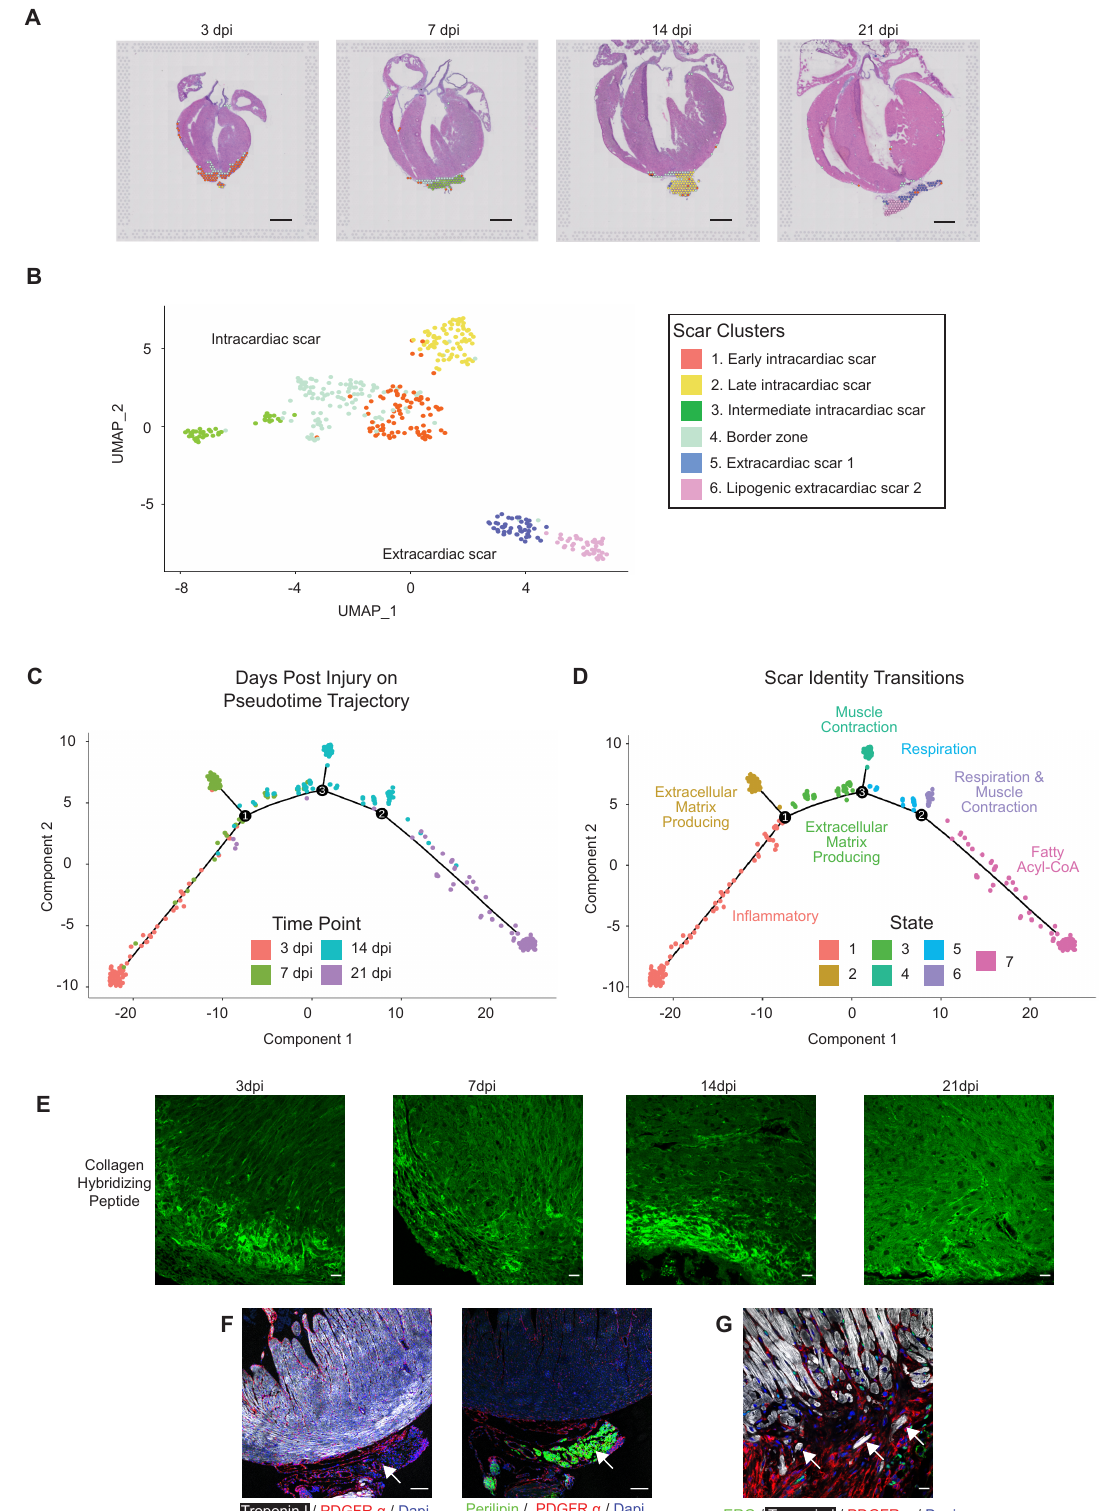
Figure 6. Spatial transcriptomics reveals the phenotypic trajectory of the regenerative scar, consisting of bi-phasic collagen deposition and culminating in scar extrusion. ( A ) Barcoded spots with